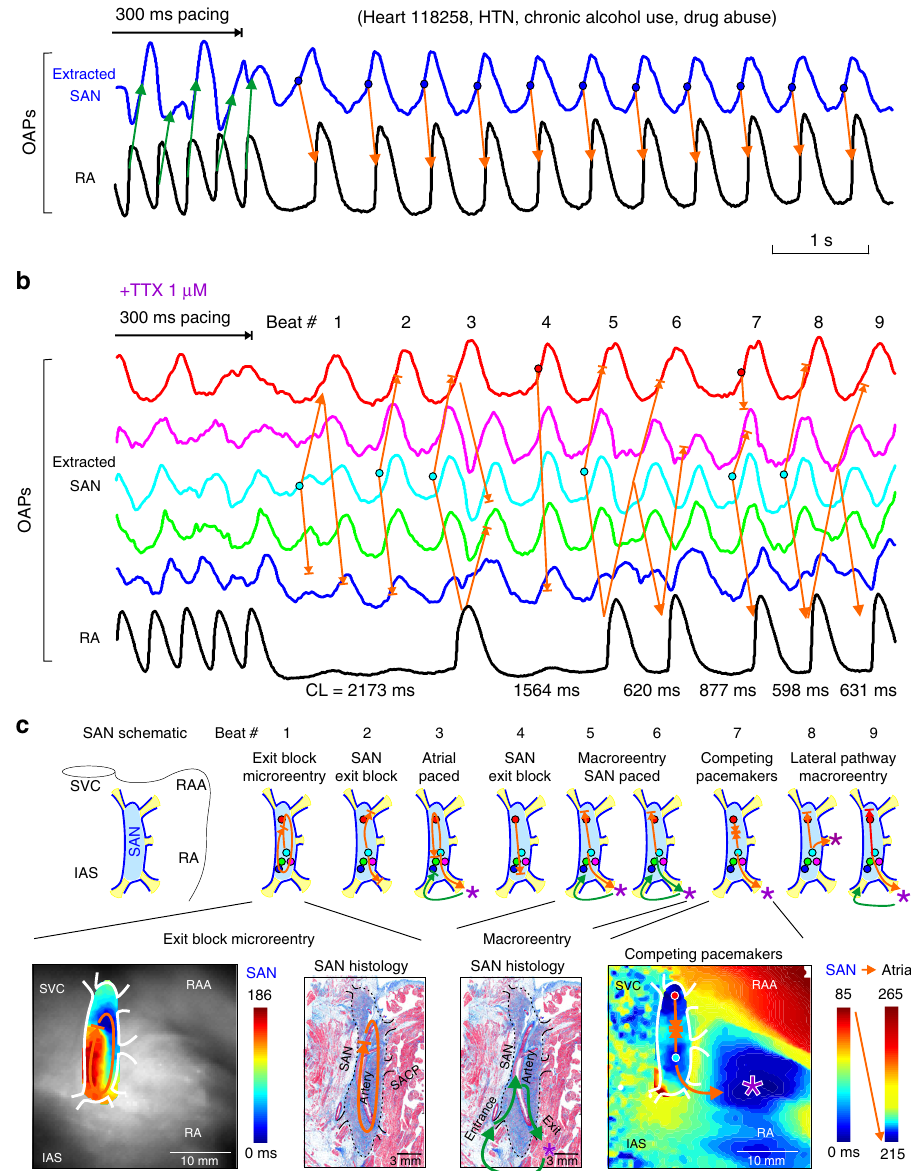
Fig. 4 Pacing-induced SAN conduction failure and reentrant arrhythmias during nNav and cNav blockade. a Optical action potentials (OAPs) show regular sinus rhythm and sinoatrial conduciton after 3.3 Hz atrial pacing at control. b OAPs show irregular sinus rhythm, atrial pause, and arrhythmia after 3.3 Hz atrial pacing during 1 µ M TTX perfusion. c SAN activation and conduction pattern revealed by high-resolution optical mapping could explain the mechanism underlying the post-pacing reentrant arrhythmia during cardiac Nav blockade by 1 µ M TTX. Top, schematic of the SAN pacemaker complex representing activation pattern for 9 post-pacing beats. Bottom, SAN activation maps and corresponding histology sections show locations of micro- reentry and macro-reentrant pathways within the SAN complex stucture. Colored dots indicate positions of sinoatrial (SAN) OAPs presented in b . Orange arrows show the conduction direction within the SAN and green arrows indicate conduction outside the SAN; asterisk indicates the earliest atrial activation site. IAS interatrial septum, RA(A) right atrial (appendage), S/IVC superior/inferior vena cava, SAN sinoatrial node, TTX